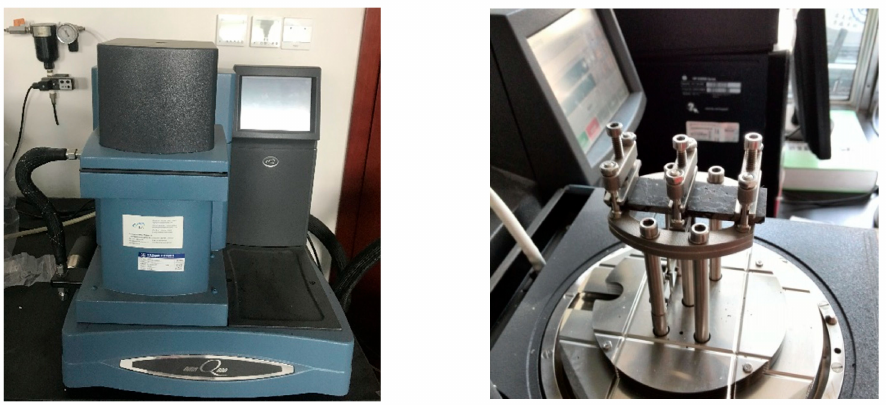
Figure 2. DMA instrument and dual cantilever clamp.